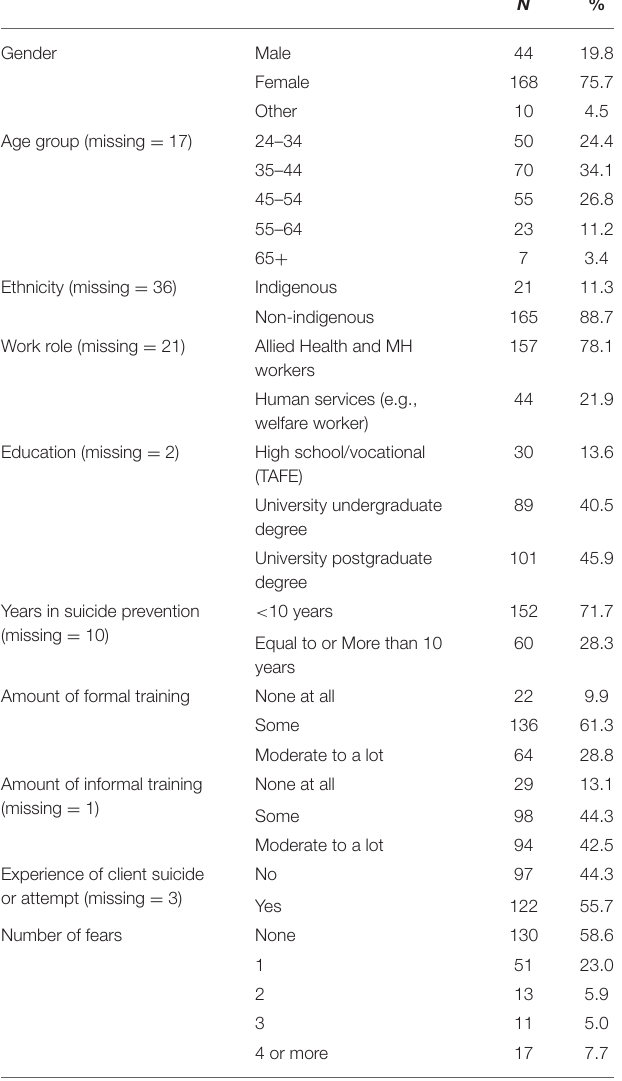
TABLE 2 | Description of study